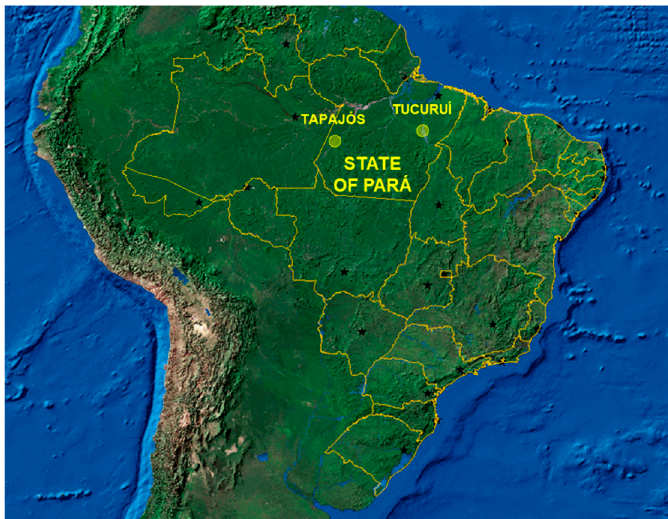
Figure 1. Map of the States of Brazil (yellow lines) and their capitals (black stars) obtained from the Instituto Brasileiro de Geografía e Estatística (IBGE, Brazil). The State of Pará and the approximate locations of the two regions (Tapajós and Tucuruí) are identified.